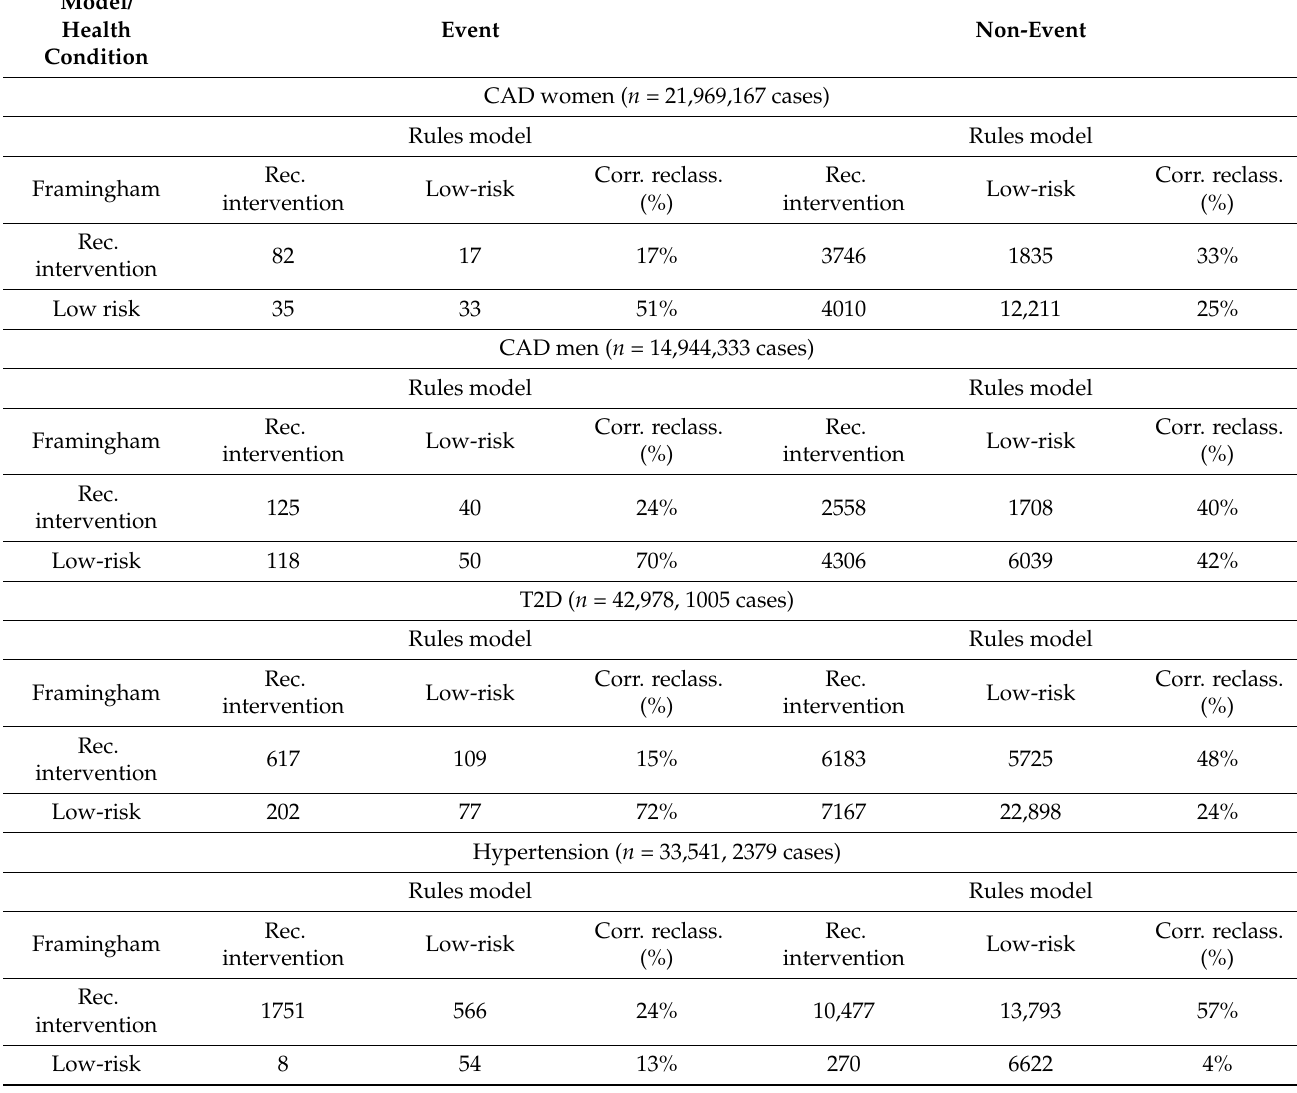
Table 4. Reclassification table for the decision rules models against Framingham risk scores. Number of individuals moving to new strata based on the updated models, split by events and